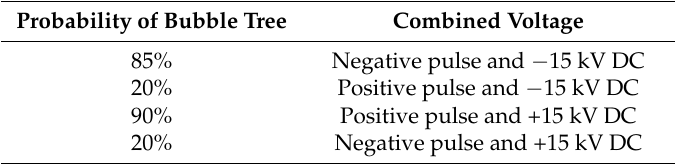
Table 3. Probability of bubble tree under different combined voltages with 60 min prestressing DC.